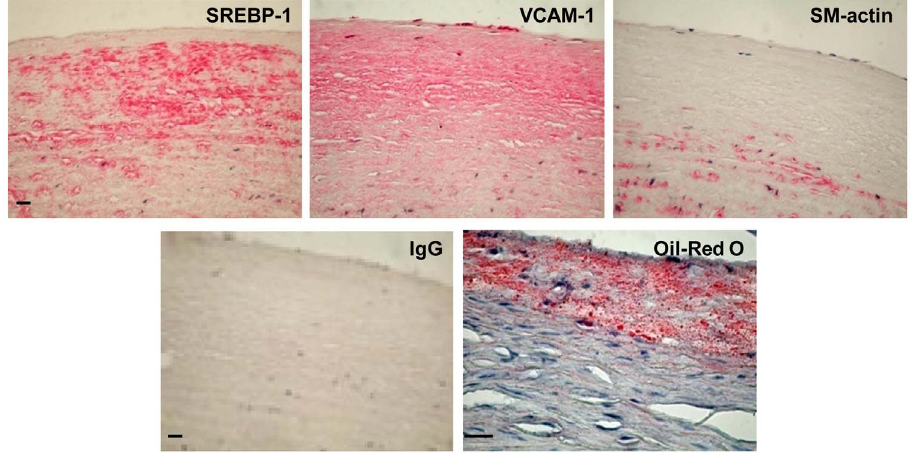
Figure 1. Positive immunostaining of SREBP-1 and VCAM-1, an important vascular inflammatory marker, in aortic sections of atherosclerotic lesions in humans with diabetes. Representative Oil Red O staining and immunostaining for SREBP-1, VCAM-1, and a -SM-actin in aortic sections of the atheromatous plaque in humans are shown (scale bars: 100 m m). Aortic sections shown were serial but not always consecutive. Positive immunostaining appeared red color. Positive staining of SREBP-1 was present primarily in subendothelial intimal lesions and lipid-rich macrophage plaque areas that were positively stained by Oil Red O. The distribution of positive staining for SREBP-1 was similar to that of VCAM-1, except VCAM-1 staining was much diffuse in lesions. The minimal staining of aortic sections in human atherosclerosis was present with the negative control staining by the incubation with non-immuno IgG substituted for the primary antibody.